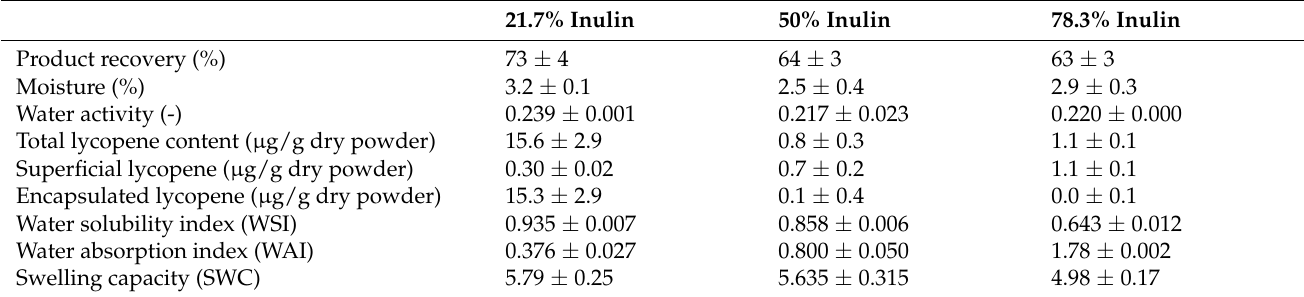
Figure 5. Inlet and outlet temperatures recorded over time during spray drying test. Results of analyses on the collected dry microparticles are reported in Table 6, as a function of inulin content in the mixture composing the coating agent. Table 6. Characterization of the dry particles produced by spray drying.